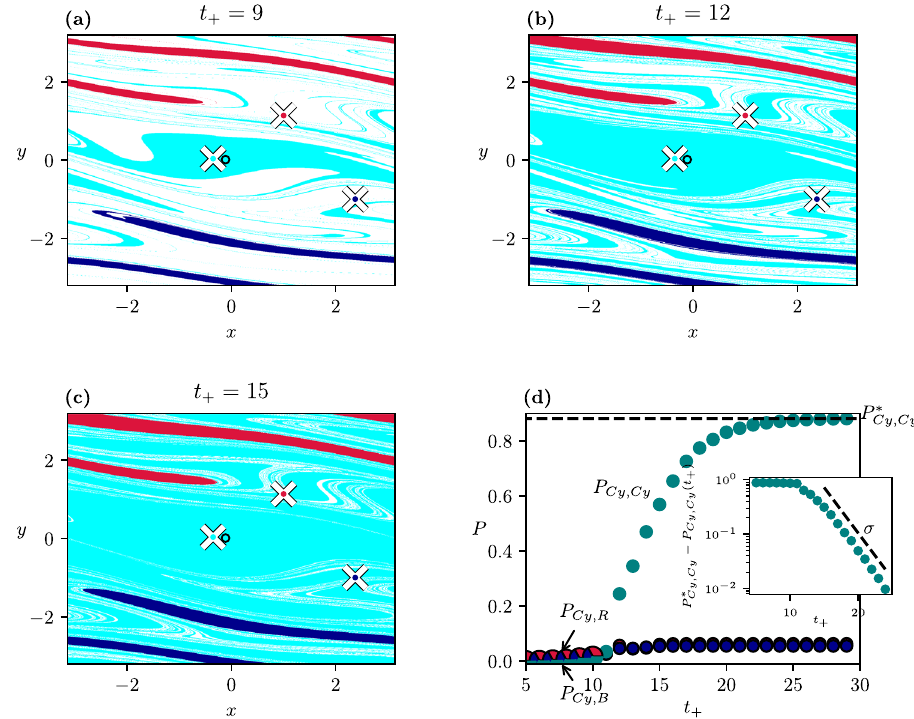
Figure 3. Basins of attraction with the scenarios of Fig. 2 observed at t + = 9( a ), 12( b ), 15( c ), at a fixed t r = 5. ( d ) Dependence of the tipping probability (into any of the 3 attractors at C + ) on t + . The inset indicates the function − ⁎ P P vs t + on a semi logarithmic scale of asymptotic slope σ = 0.385 ± Cy Cy Cy Cy , ,